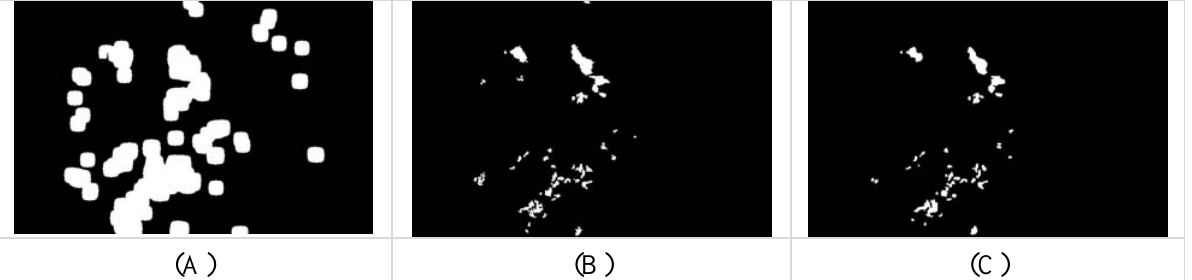
Figure 6. Comparison of exudates detection. (A) Coarse segmentation using FCM clustering. (B) Fine segmentation using morphological reconstruction (C) Ground truth image.